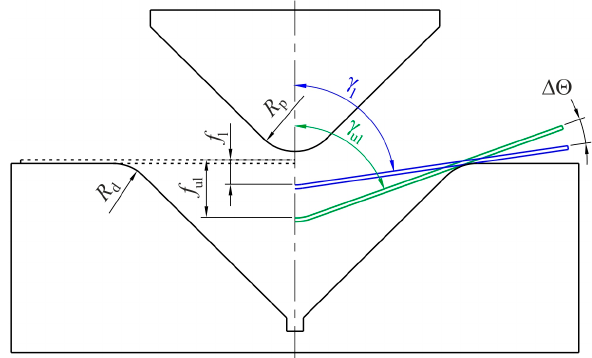
Figure 3. The schematic for the measurement of springback.